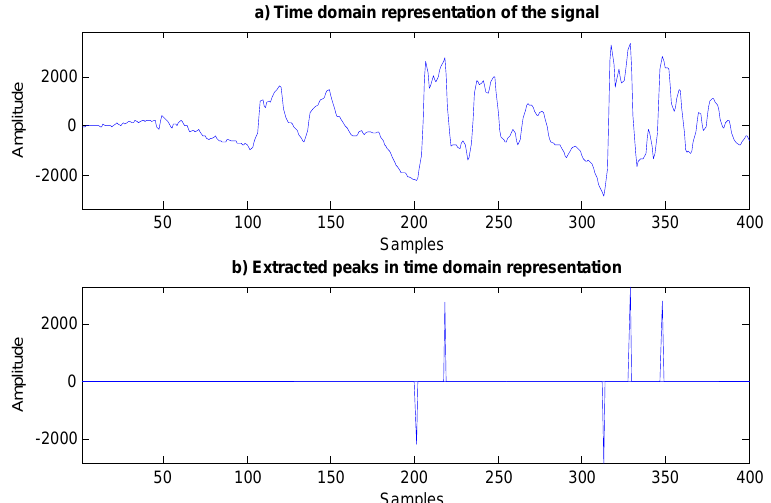
Figure 4. The time domain representation of the frame at the boundaries of the transition from the unvoiced to the voiced segment of the audio signal: ( a ) The time domain representation of the signal. ( b ) Extracted peaks in the time domain representation.